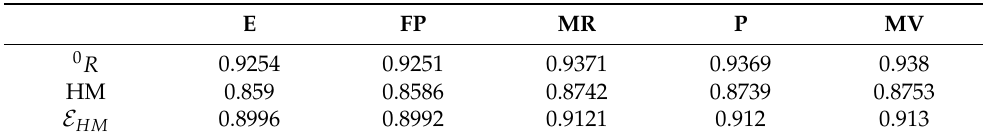
Table 3. Coefficient of determination R 2 with the physicochemical properties of potential drugs to be used which can be used as treatment of COVID-19 along with 0 R , HM and E HM . E